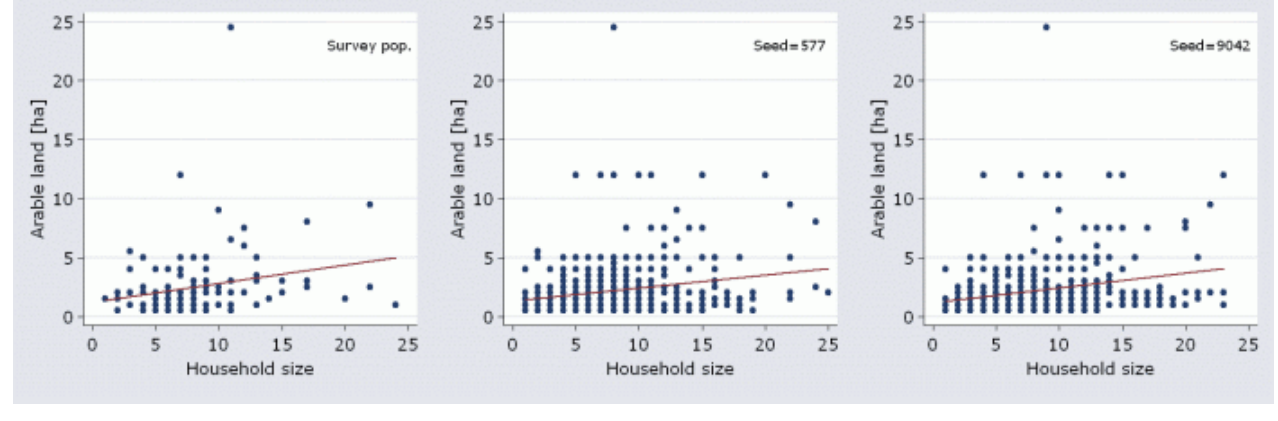
Fig. 7. Correlation between household size and amount of arable